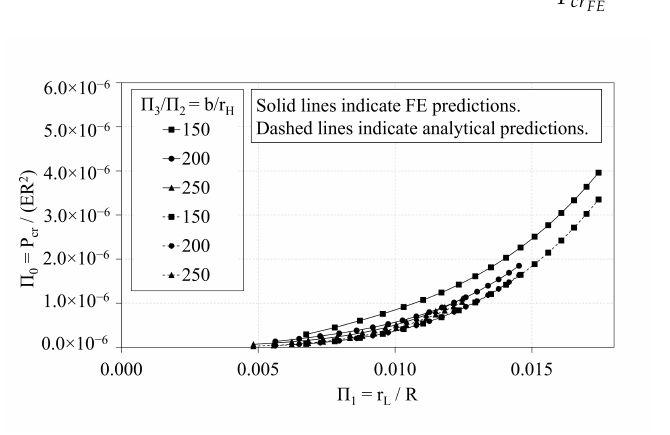
Figure 9. OLC Π 0 vs. Π 1 Analytical and FE predictions [26].